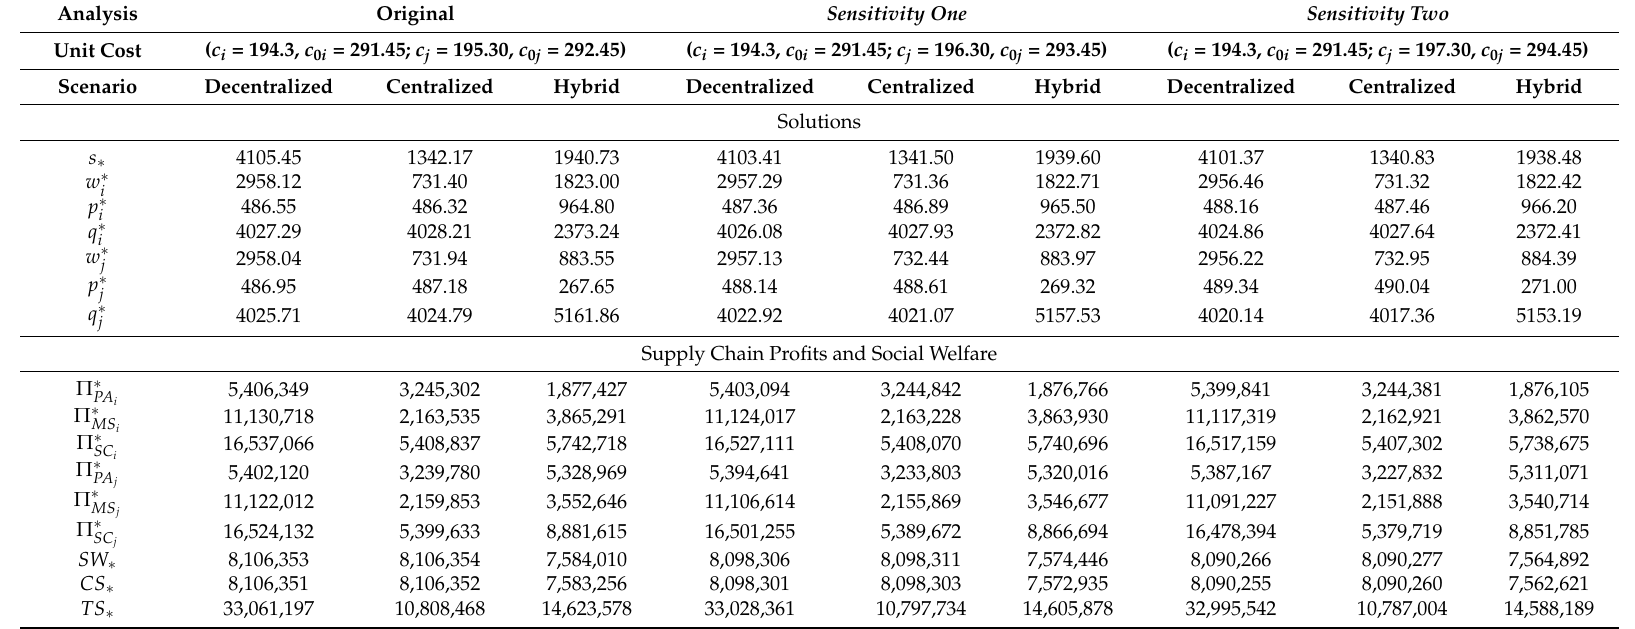
Table 2. Numerical and sensitive analysis results of dual competing PV supply chains under social welfare